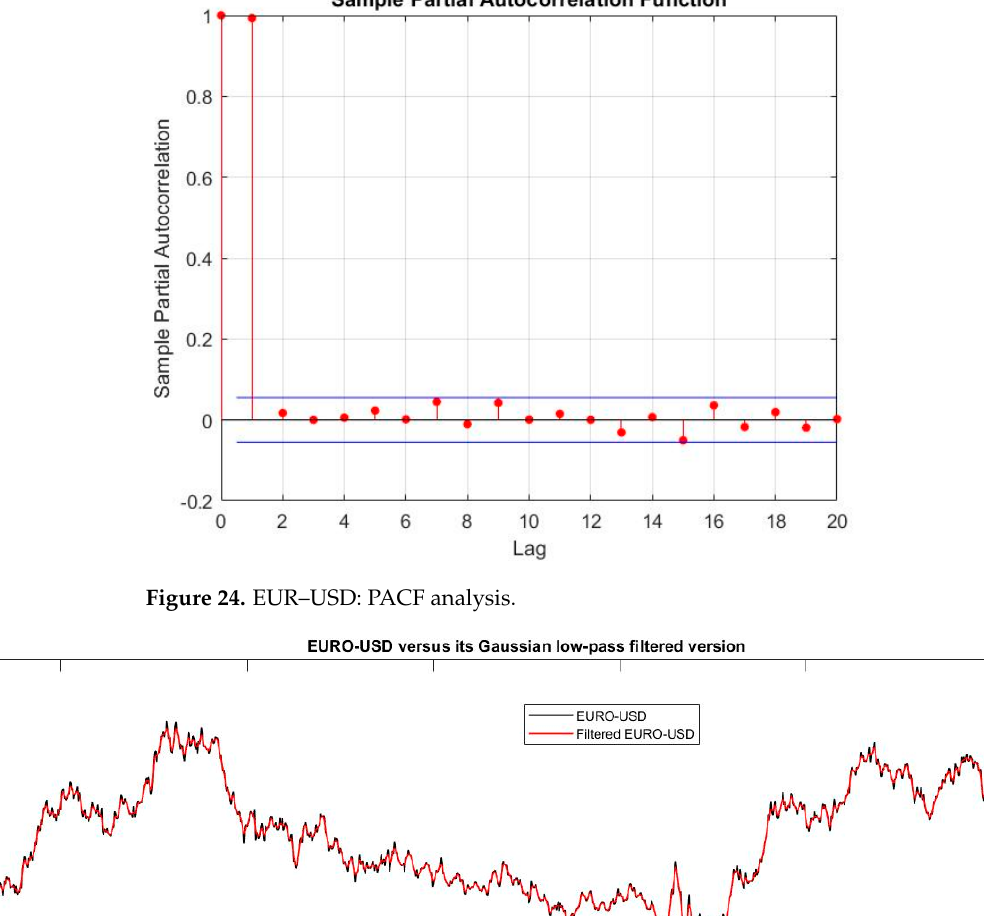
Table 3. EUR–USD: accuracy comparison.